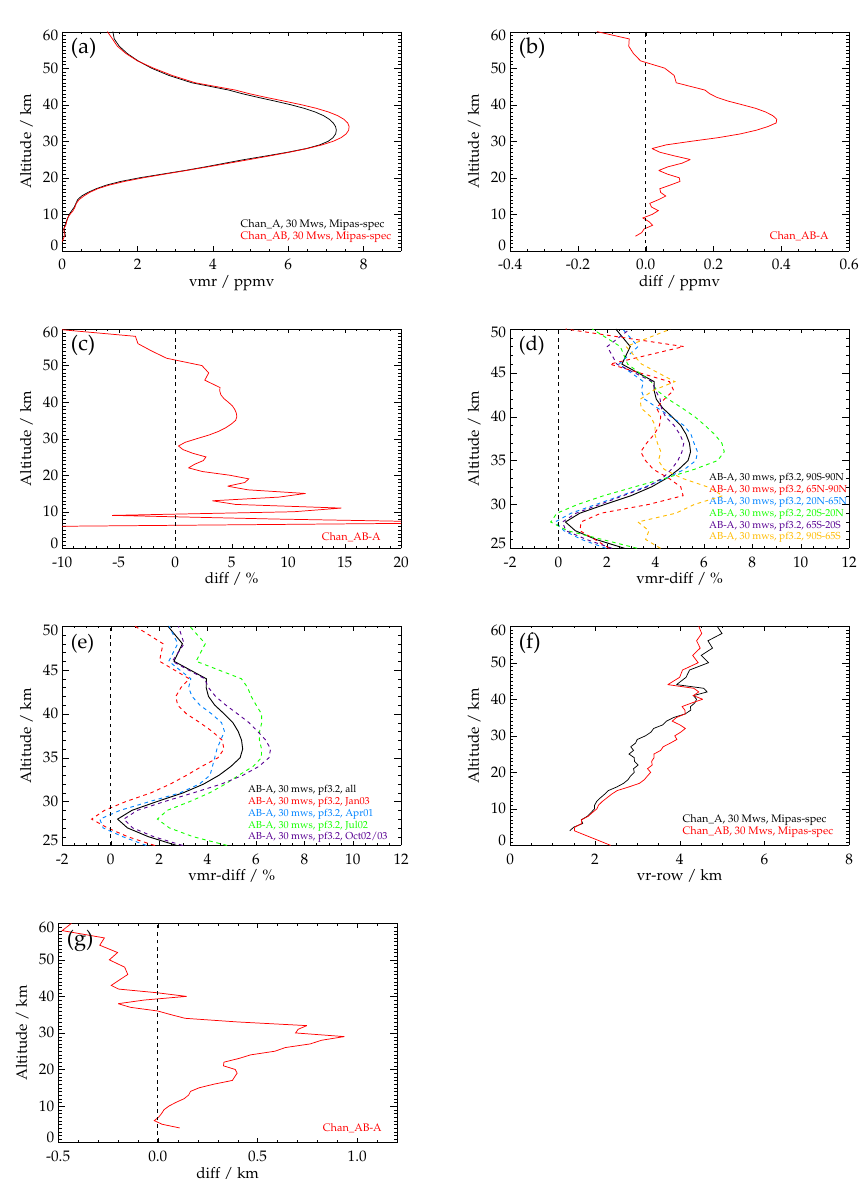
Figure 1. (a) Mean ozone profiles retrieved in MIPAS channels A (black) and AB (red) using the MIPAS pf3.2 spectroscopy. All profiles of 59 orbits from 3 January, 1 April, 2 July and 2–3 October 2009 were averaged. (b) Absolute and (c) relative differences between the profiles retrieved in channels AB and A. (d) Relative AB–A differences for all data (solid line) and in the latitude bands 65–90 ◦ N, 20–65 ◦ N, 20 ◦ S–20 ◦ N, 65–20 ◦ S and 90–65 ◦ S (dashed lines; see legend). (e) Relative AB–A differences for all data (solid line), 3 January, 12 April, 2 July and 2–3 October 2009 (dashed lines, see legend). Note the different height scales for the latitudinal and seasonal displays. (f) Mean vertical resolution of the MIPAS channel A (black) and AB retrievals (red). (g) Difference between the vertical resolution of MIPAS channel AB and A